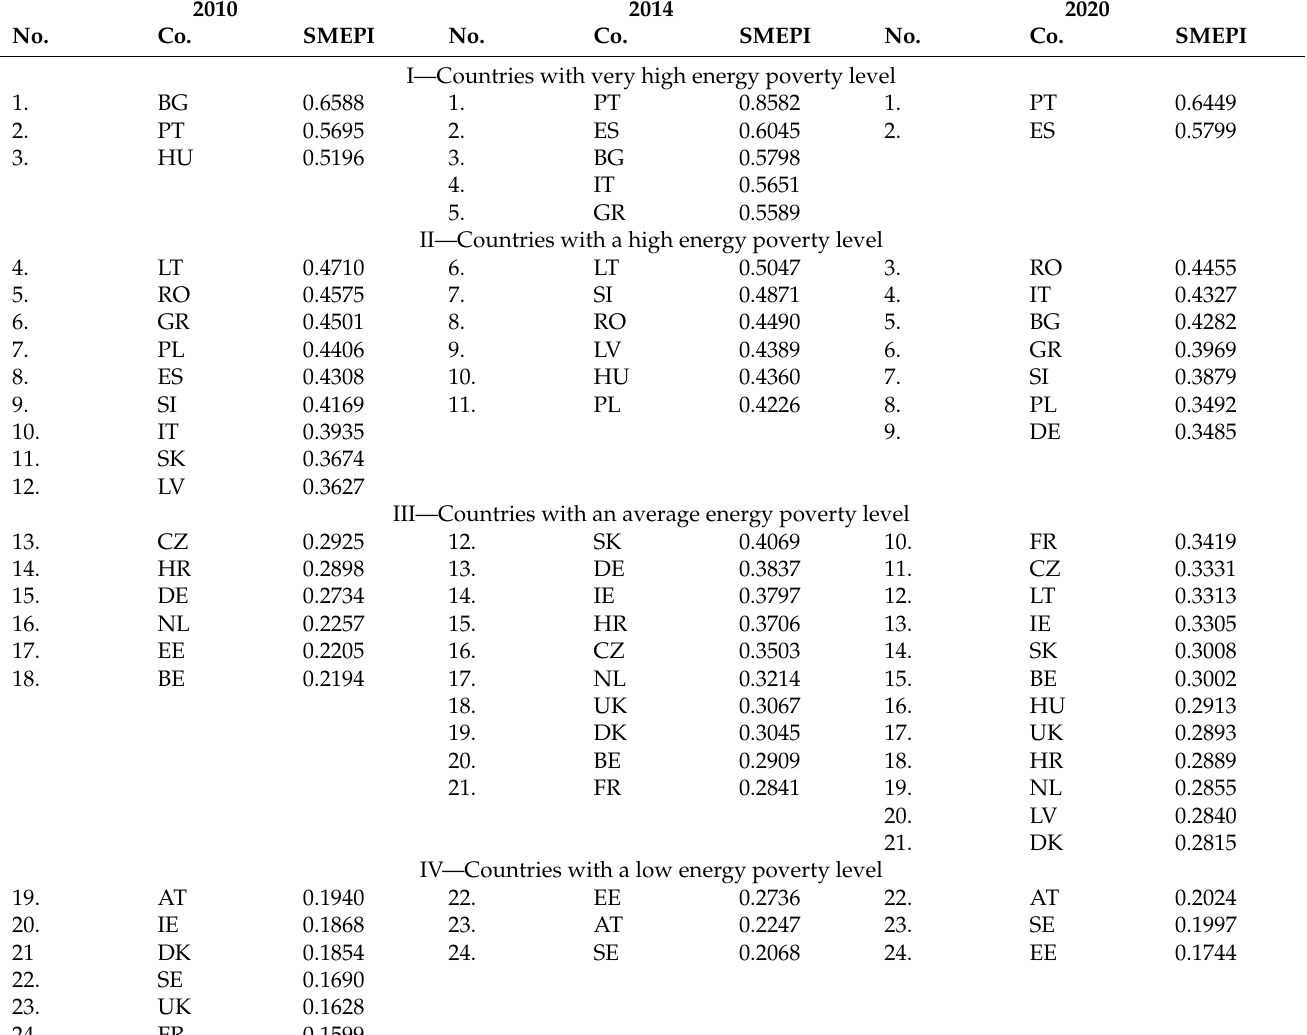
Table 2. The result of analysis of the SMEPI in 2010, 2014 and